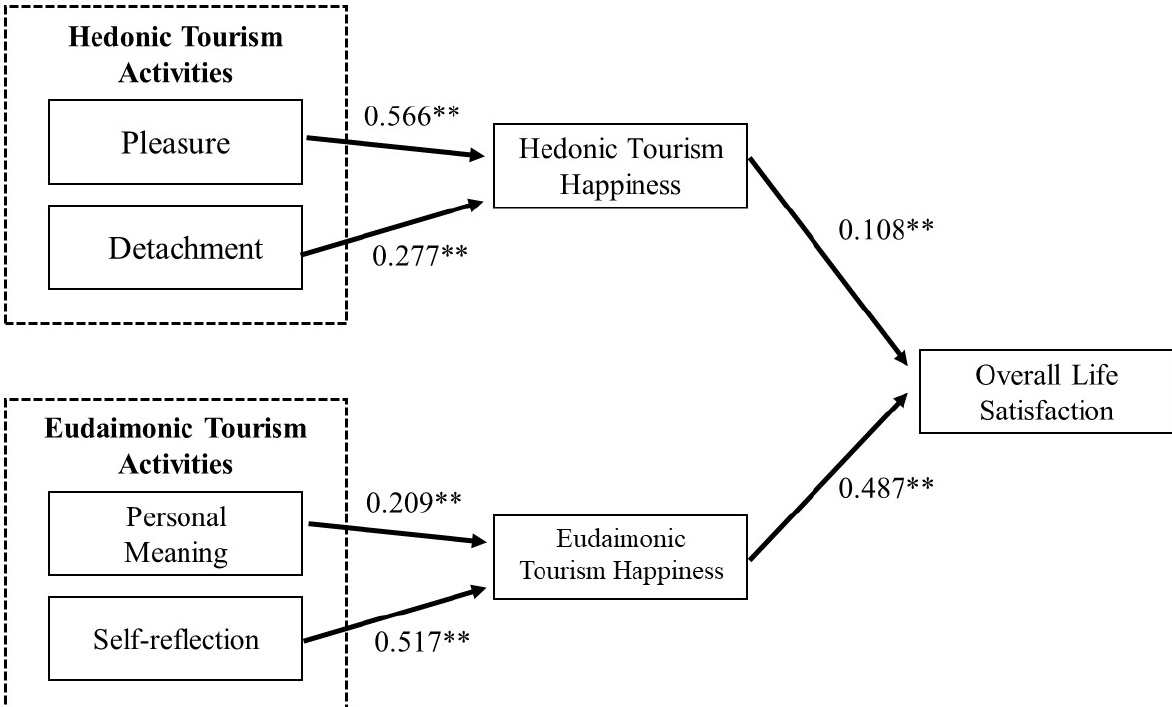
Figure 3. Path analysis results. Table 8. Results of Asymmetry Effect.